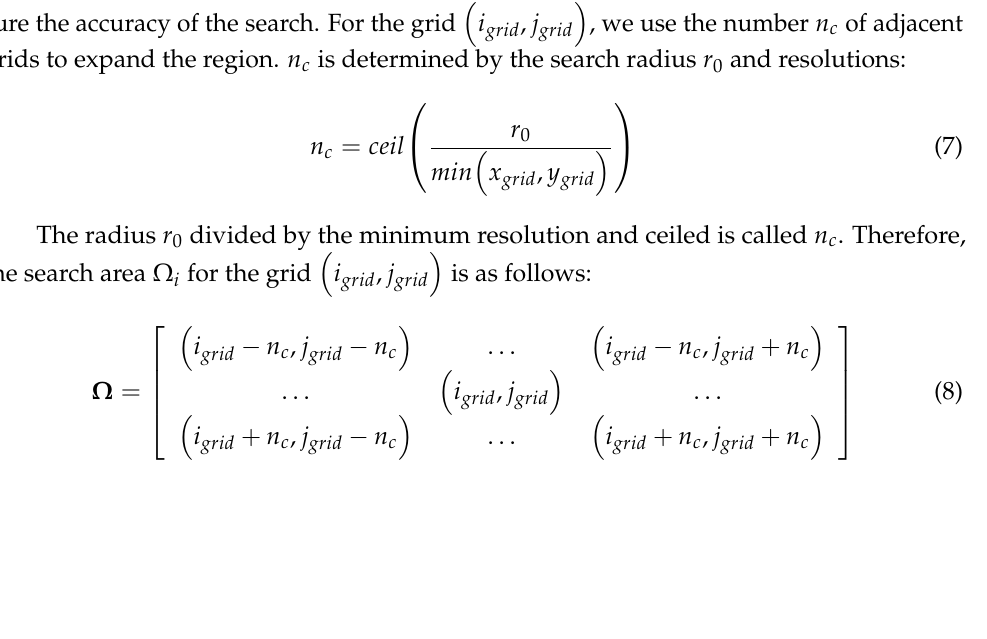
, we use the number